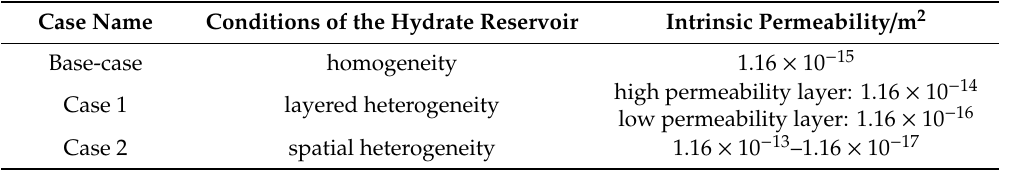
Table 2. The designed simulation scenarios.